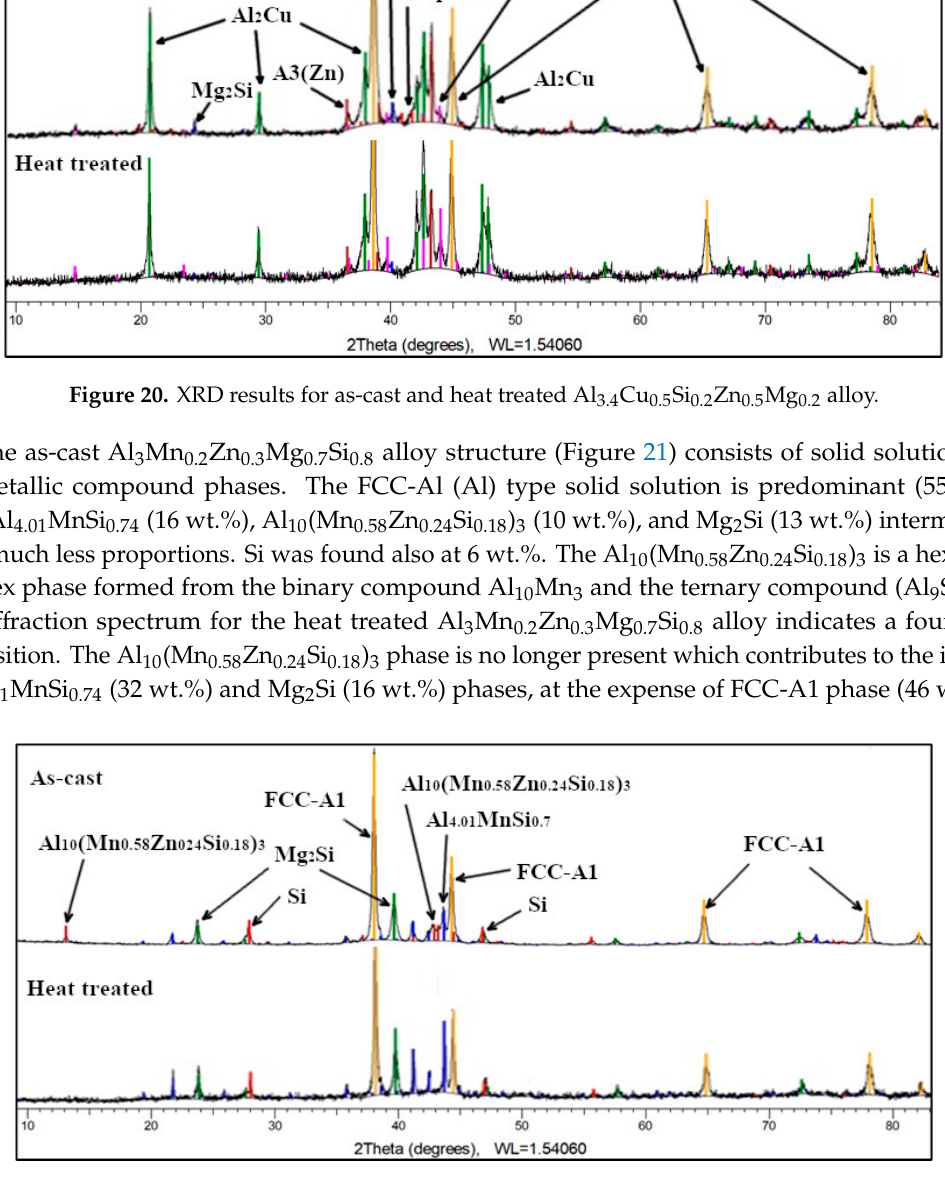
Figure 21. XRD results for as-cast and heat treated Al 3 Mn 0.2 Zn 0.3 Mg 0.7 Si 0.8 alloy.